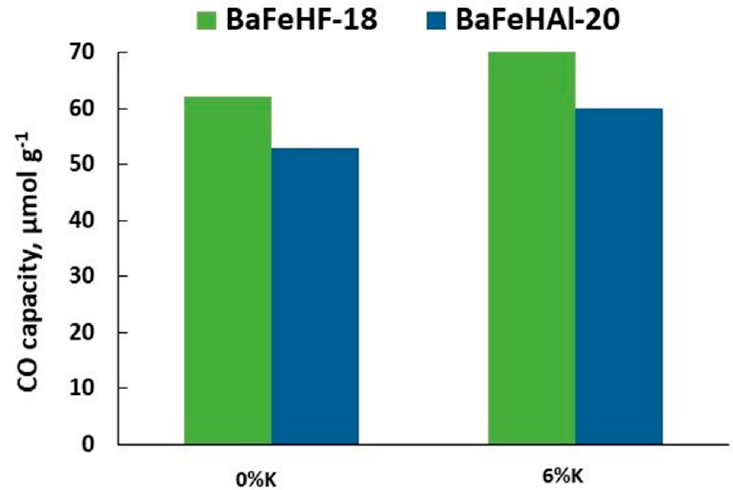
Figure 6. Comparison of the CO capacity in RWGS-CL of as-prepared and K-promoted BaFeHAl and BaFeHF at 350 °C.